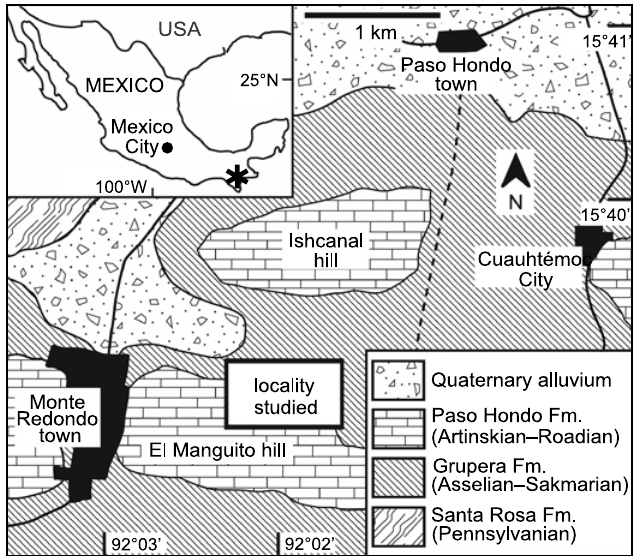
Fig. 1. Map of Mexico and geological map of the studied